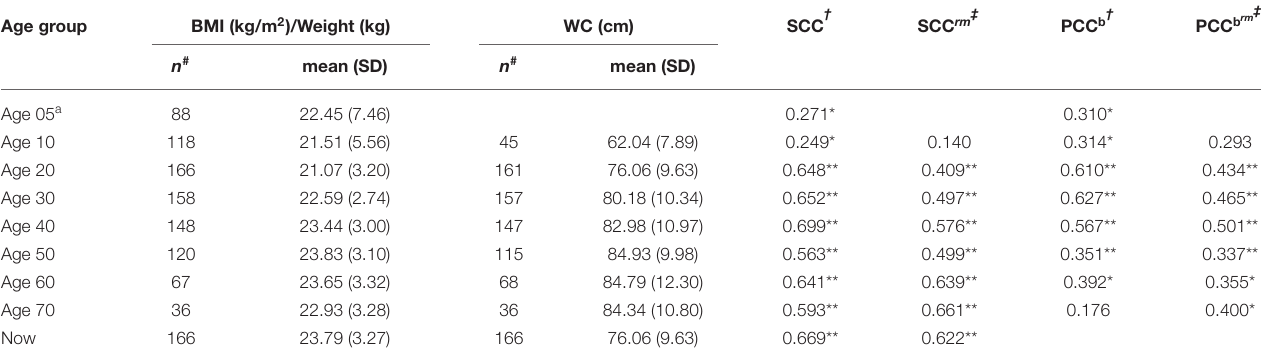
# Sample sizes vary due to miss value. † Body shape and BMI. ‡ Body shape and